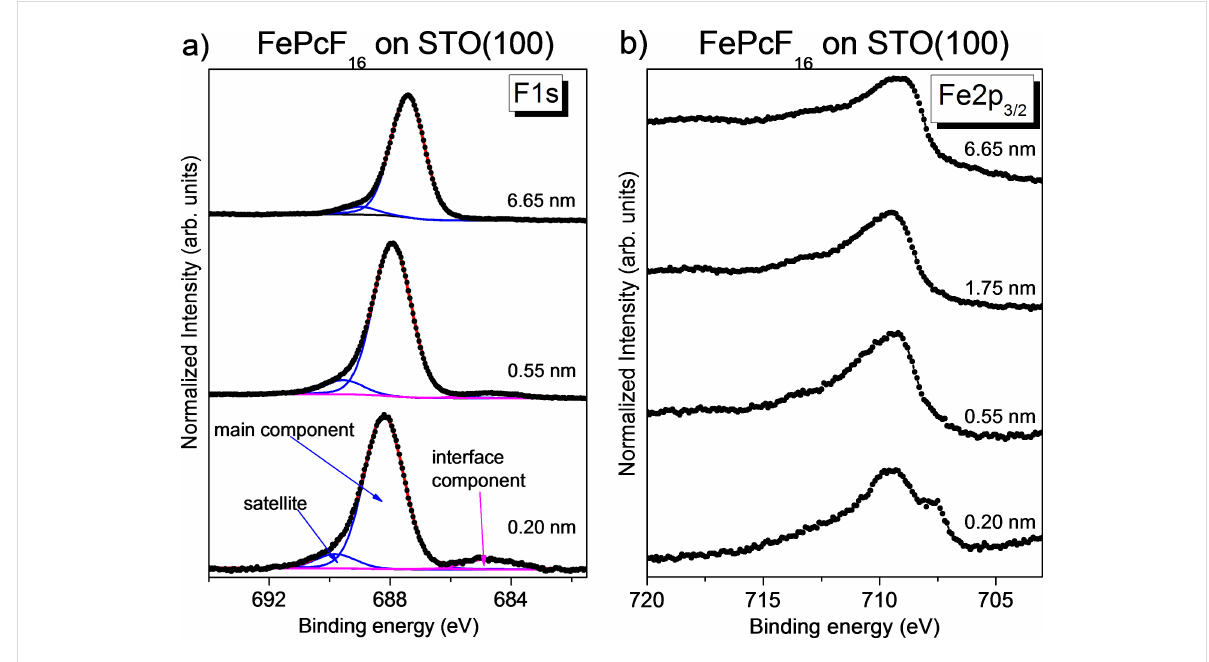
Figure 6: FePcF 16 on STO(100). Thickness-dependent F 1s (a) and Fe 2p 3/2 (b) core level spectra. The interface component in the Fe 2p 3/2 spectra (see arrow) is similar to that in the FePc spectra (Figure 5).